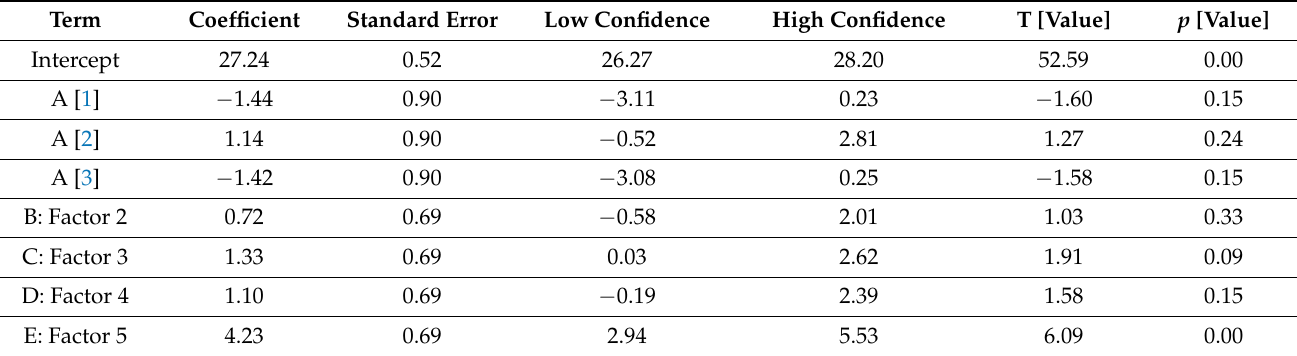
Table 4. Regression Information—S/N ratio.